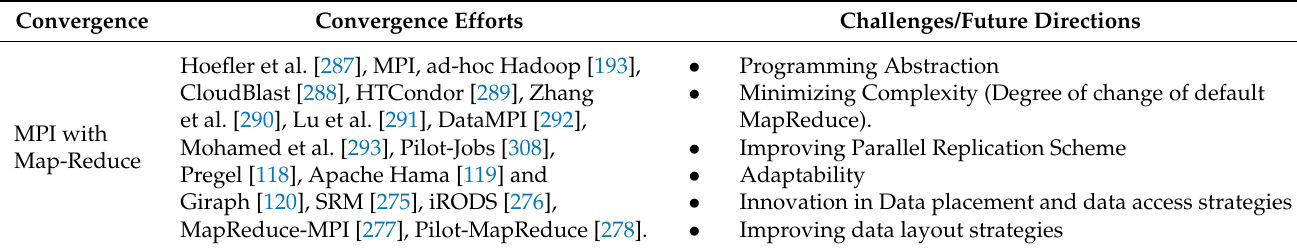
Table 2. Data Locality-aware HPC and Big Data Convergence